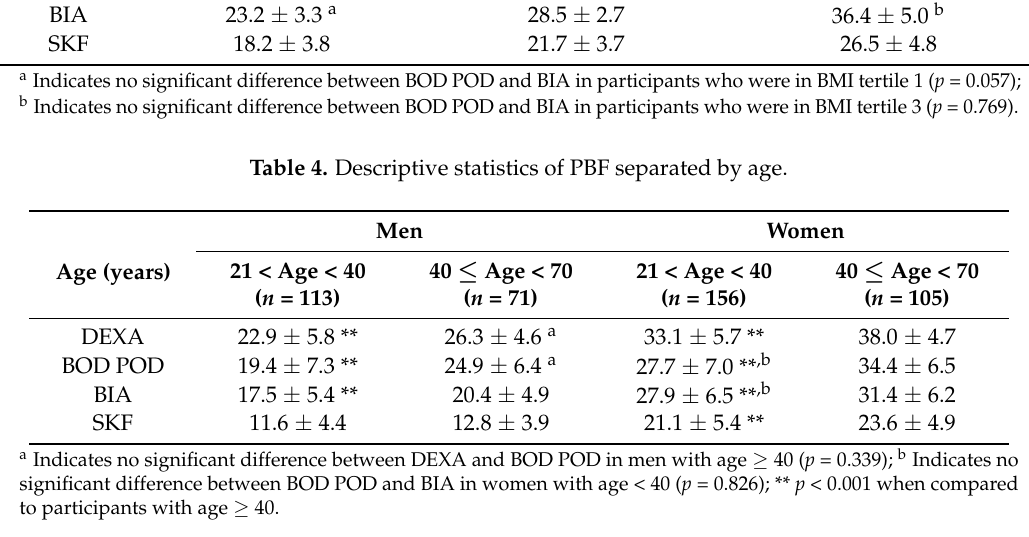
Table 5. Age-, ethnicity- and BMI-adjusted partial correlation coefficients of PBF measured by DEXA, BODPOD, BIA and SKF, respectively, separated by